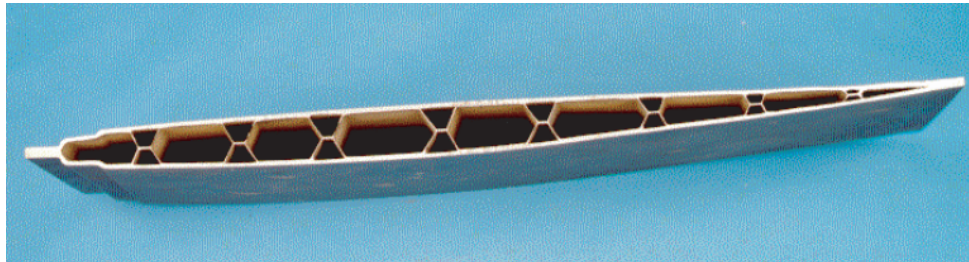
Figure 11. A cross-section of one of the canards from the Eurofighter